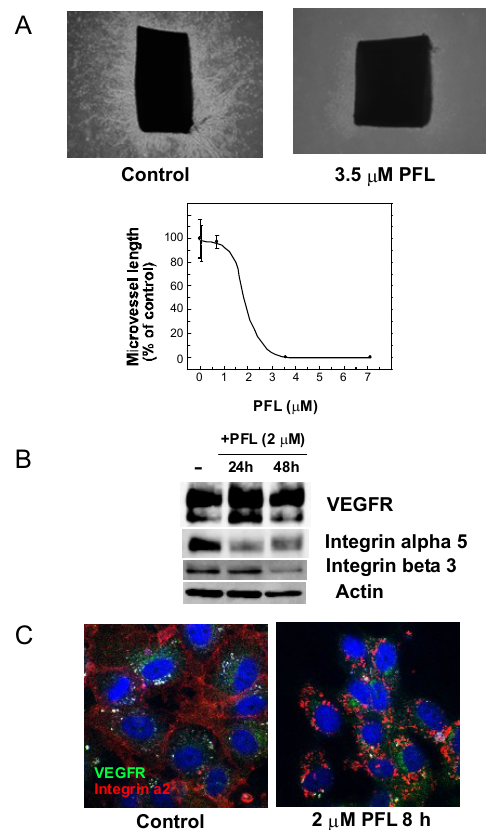
Figure 3. PFL inhibition of angiogenesis. ( A ) Effect of PFL on ex vivo angiogenesis of rat aortic rings. Representative data of PFL inhibition of angiogenesis are shown. The figure shows results of one experiment that was replicated at least twice with similar results. Rat aortic rings were embedded in collagen gel and maintained at 37 ° C for 7 days in the presence or absence of various concentrations of PFL. Microvessel length was measured using Adobe Photoshop software CS3. Each value represents the mean and SD ( n = 6). ( B ) Change of VEGFR integrin levels in human umbilical vein endothelial cells (HUVECs) treated with PFL. HUVECs were incubated with 2 μM PFL in HUVEC medium for 24 and 48 h on a vitronectin-coated plate with VEGF stimulation. Protein levels were detected by immunoblotting with a monoclonal antibody against each protein. ( C ) Cellular distribution of VEGFR and integrin α 2 after PFL treatment. Altered cellular distribution of VEGFR (green) and integrin α 2 (red) with PFL treatment was observed by immunofluorescence microscopy. HUVECs were incubated with 2 µ M PFL in HUVEC medium for 8 h on vitronectin-coated cover glass with VEGF stimulation. Nuclei were stained with